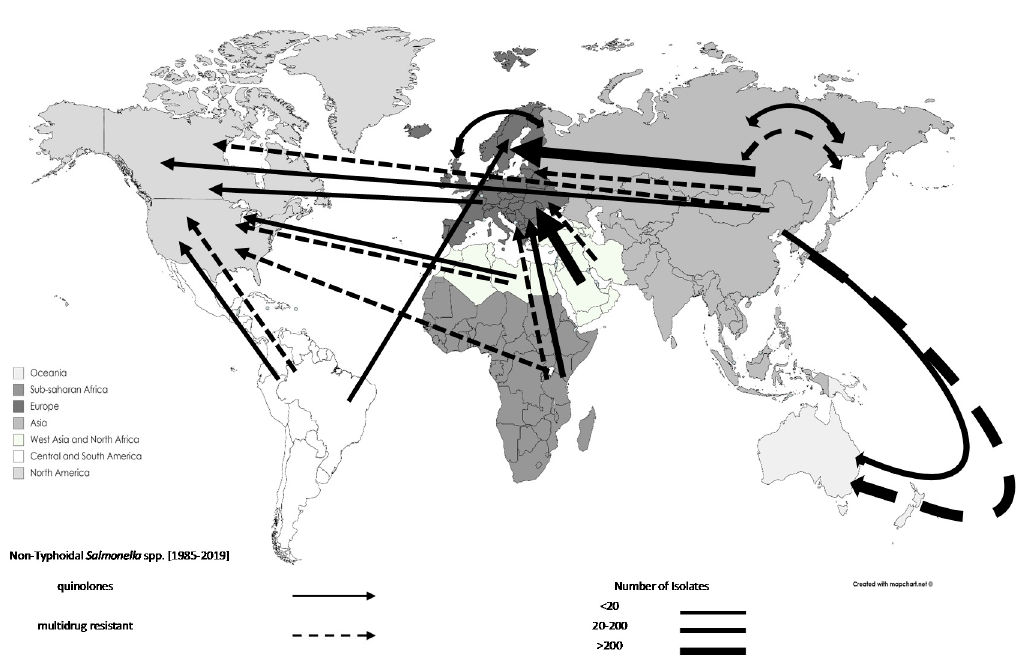
Figure 4. Travel-related antimicrobial resistant nontyphoidal Salmonella spp. movements, 1990–2019: data are shown by arrows representing antimicrobial resistant isolate movements, where the arrowhead represents the destination and the base of the arrow represents the source. Thus, double-headed arrows represent movements between the same regions. Different regions are represented by different shades.